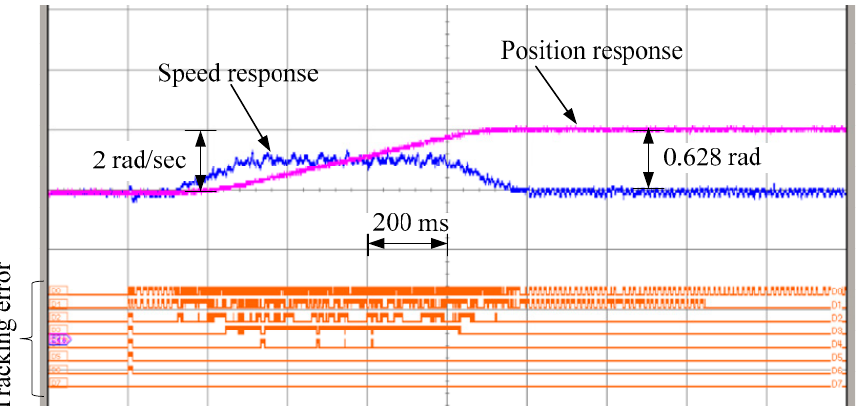
Figure 18. The experimental responses of position and speed without load.